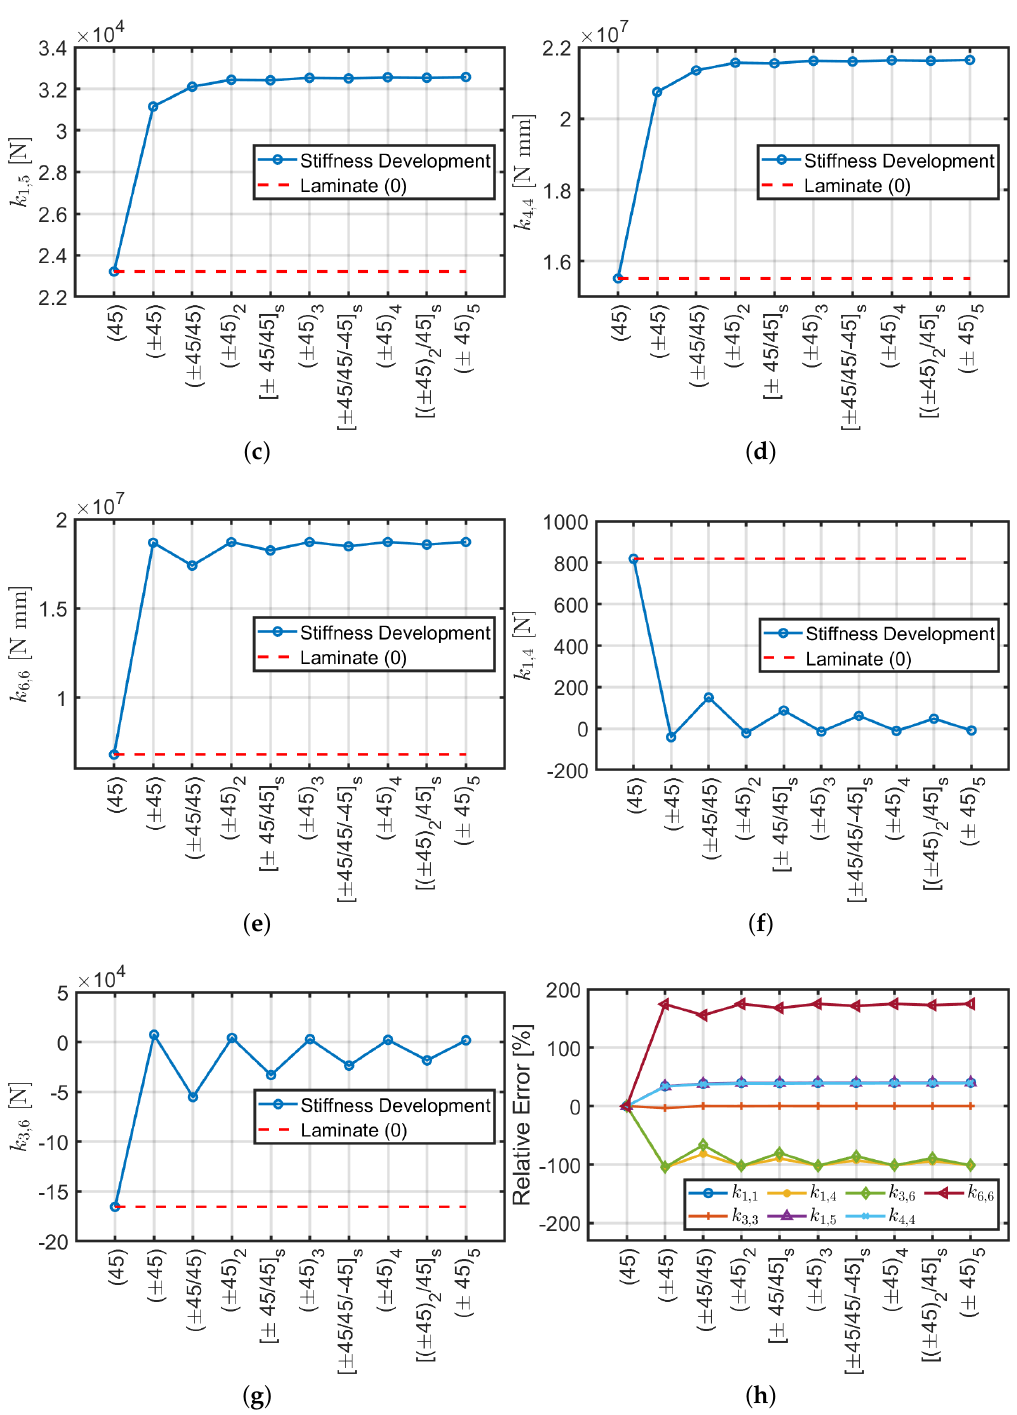
Figure 5. Stiffness trends with respect to number of plies ( a – g ) and relative error with respect to orthotropic configuration ( h